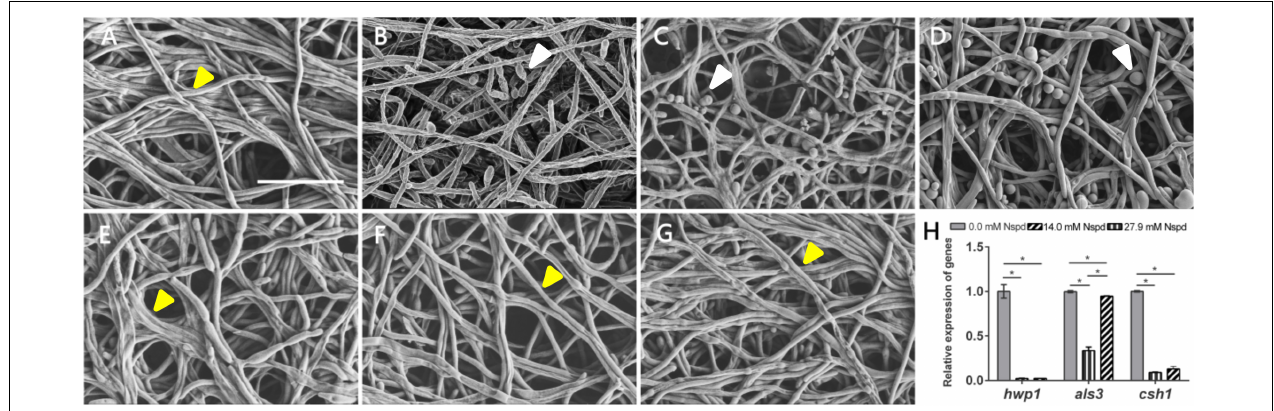
FIGURE 3 | SEM images of C. albicans biofilms and virulence related gene expression influenced by Nspd on the C. albicans biofilms. (A–E) SEM images of C. albicans biofilms challenged by Nspd at various concentrations (0, 111.7, 55.9, 27.9, and 14.0 mM, respectively). (F) 80 µ M fluconazole. (G) Vehicle (0.08% ethanol). More yeasts (indicated by white arrows) were formed in 111.7 mM (B) , 55.9 mM (C) , and 27.9 mM (D) Nspd groups. There were no yeasts but hyphae form of fungal cells (indicated by yellow arrows) in mature biofilms of blank control (A) , 14.0 mM Nspd group (E) , 80 µ M fluconazole (F) , and vehicle (G) groups.